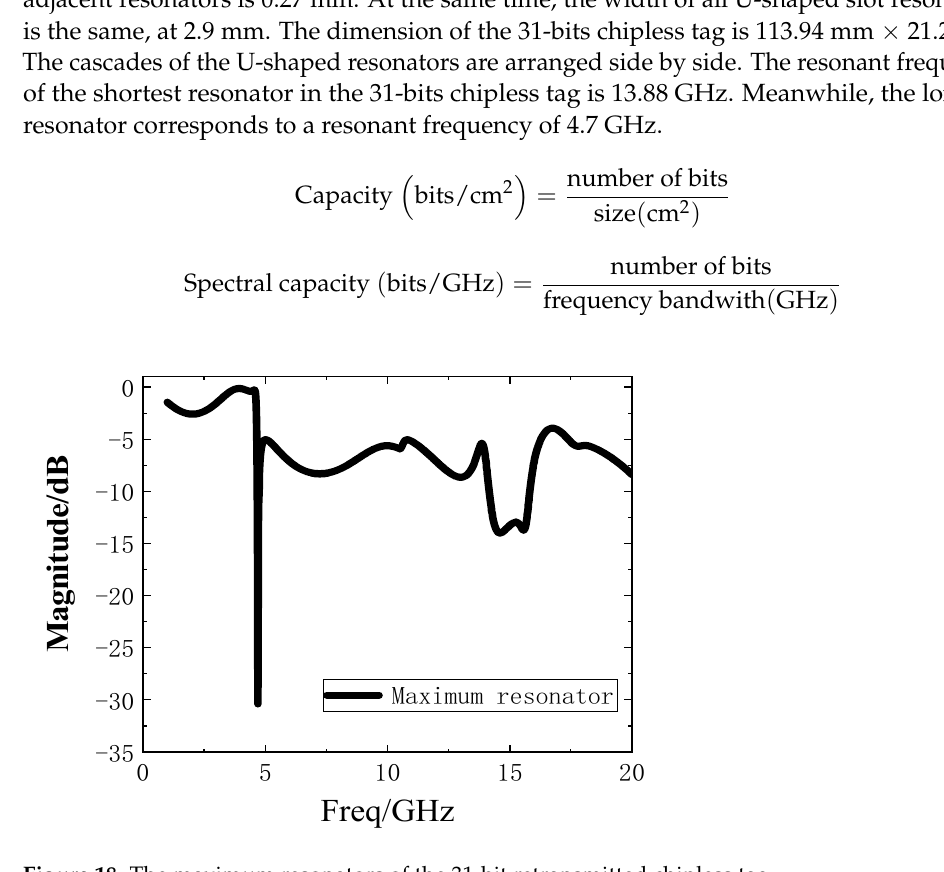
adjacent resonators is 0.27 mm. At the same time, the width of all U-shaped slot resonators